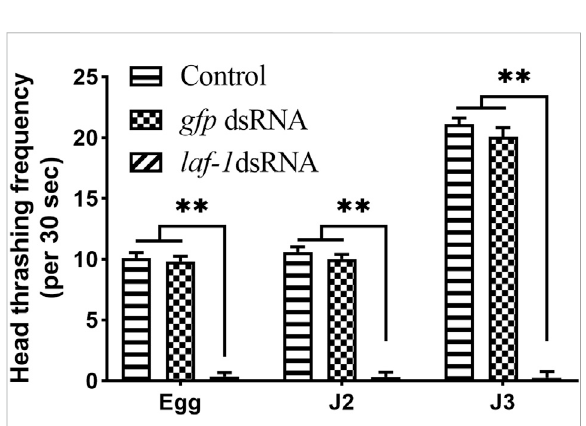
FIGURE 7 Head swing frequency of B. xylophilus after RNAi soaking at different developmental stages. Egg, larvae hatch from the treated embryo-stage; J2, the second-stage juveniles after 24 h treatment; J3, the third-stage juveniles after 24 h treatment. Control, the no probe control, means that nematodes were treated with soaking buffer alone; gfp dsRNA, the negative control means that nematodes were treated with gfp dsRNA; Bxy-laf-1 dsRNA,meansthatnematodesweretreatedwith Bxy-laf-1 dsRNA. Asterisks indicate a signi fi cant difference between two groups ( p < 0.05). Error bars represent standard error of